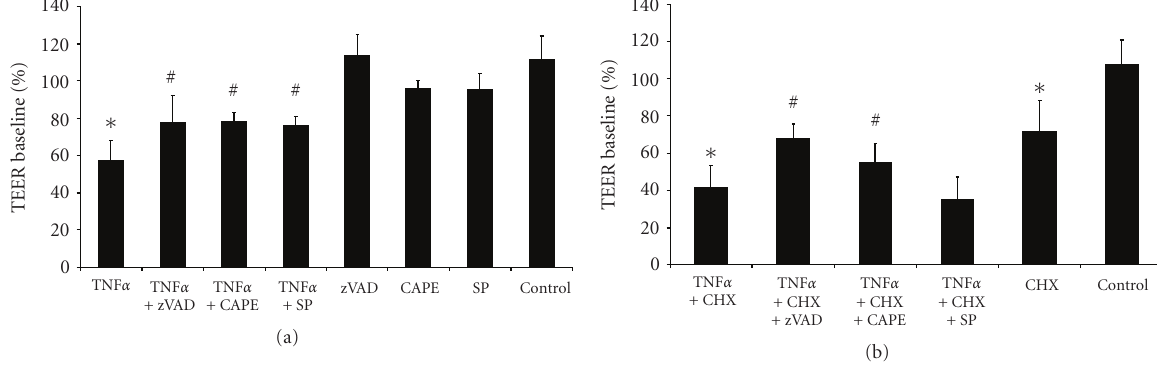
Figure 2: TNF α -induced decrease of TEER in PCPEC is caspase- and NF- κ B-dependent. E ff ects of the pan-caspase inhibitor zVAD-fmk (10 μ M), the NF- κ B inhibitor CAPE (5 μ M), and the JNK-inhibitor SP600125 (10 μ M) on TNF α -induced decrease of TEER in PCPEC were determined at 24 hours. PCPECs were stimulated apically with TNF α (100ng/mL) with (b) or without (a) cycloheximide (1 μ g/mL). The TEER results are expressed as a percentage of baseline. The data shown are mean ± SEM of four independent experiments, each performed in duplicate. # P-value of < . 05 compared to TNF α stimulated PCPEC without inhibitor; ∗ P-value of < . 05 compared to unstimulated